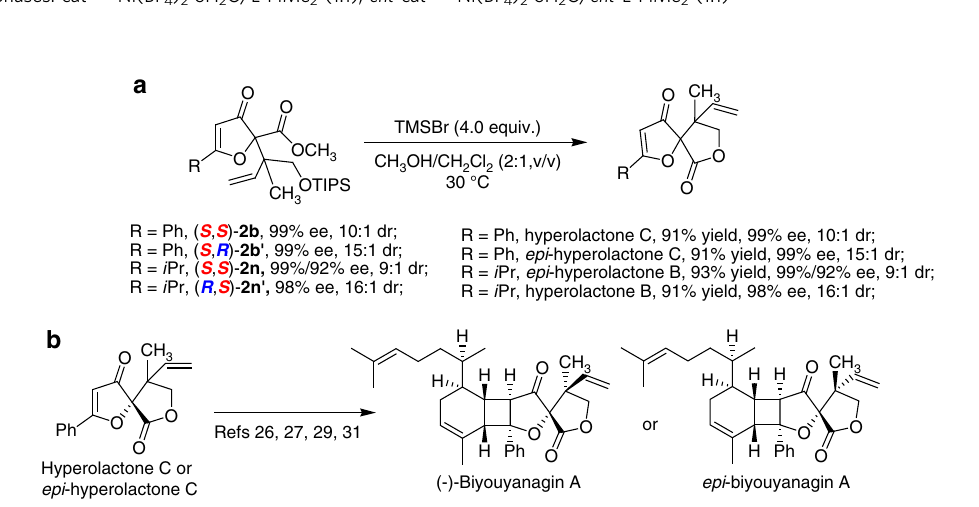
Fig. 5 Stereodivergent synthesis of natural products hyperolactones B, C, ( − )-biyouyanagin A, and their epimers. a The deprotection/lactonization transformation of the product 2b , 2b ′ , 2n and 2n ′ . b Formal synthesis of ( − )-biyouyanagin A and epi -( − )-biyouyanagin